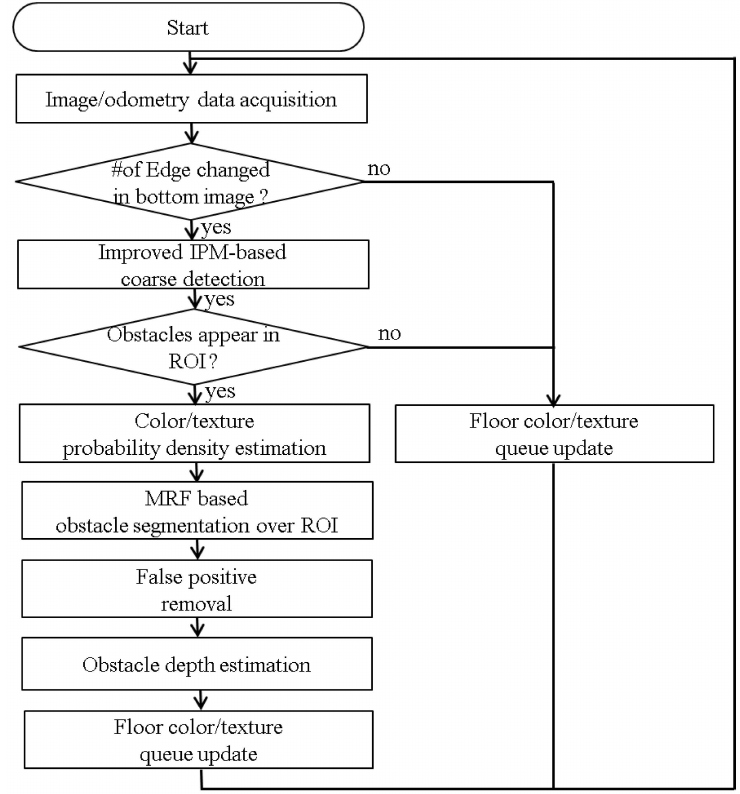
Figure 3. Flowchart of the overall